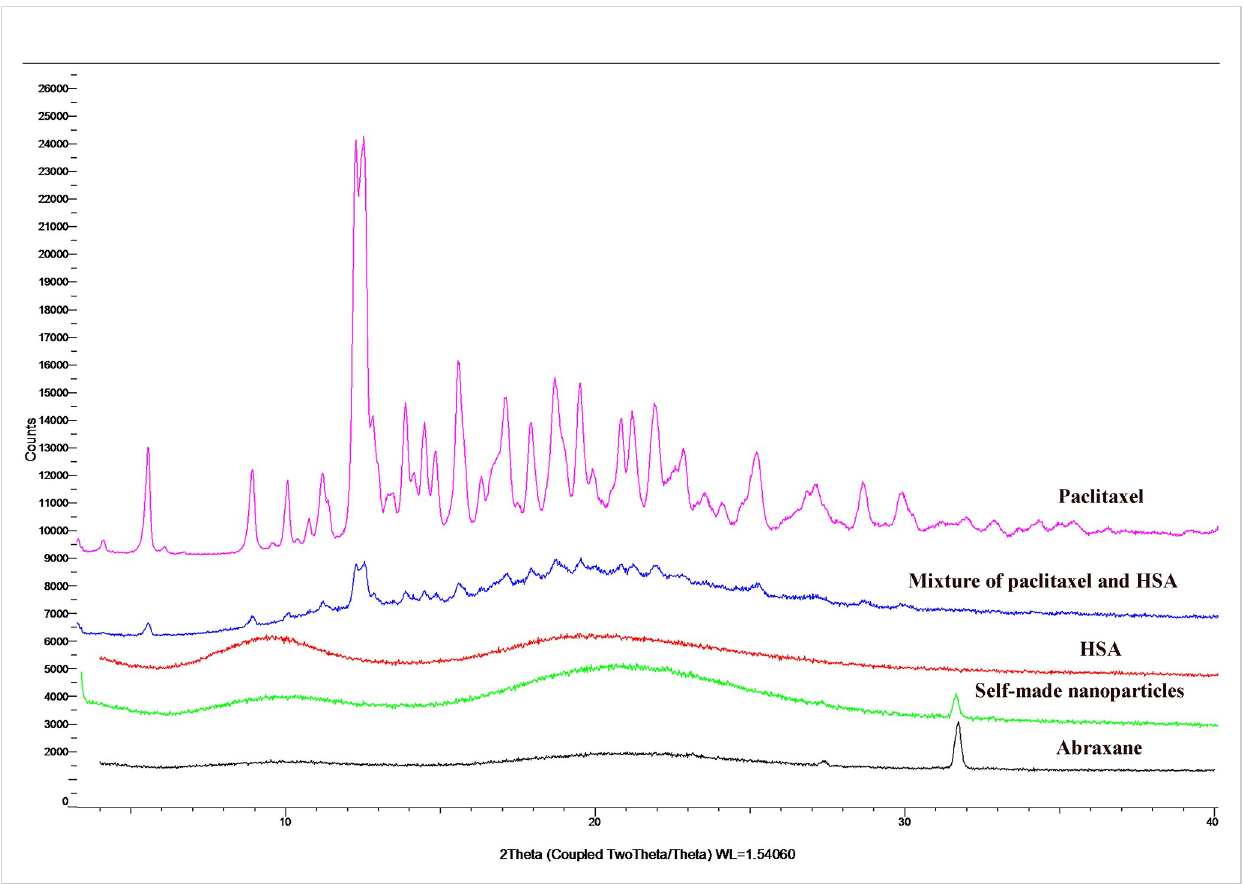
Fig 4. X-ray diffraction patterns of HSA, paclitaxel, physical mixtures of HSA and paclitaxel, Abraxane, and self-made nanoparticles.